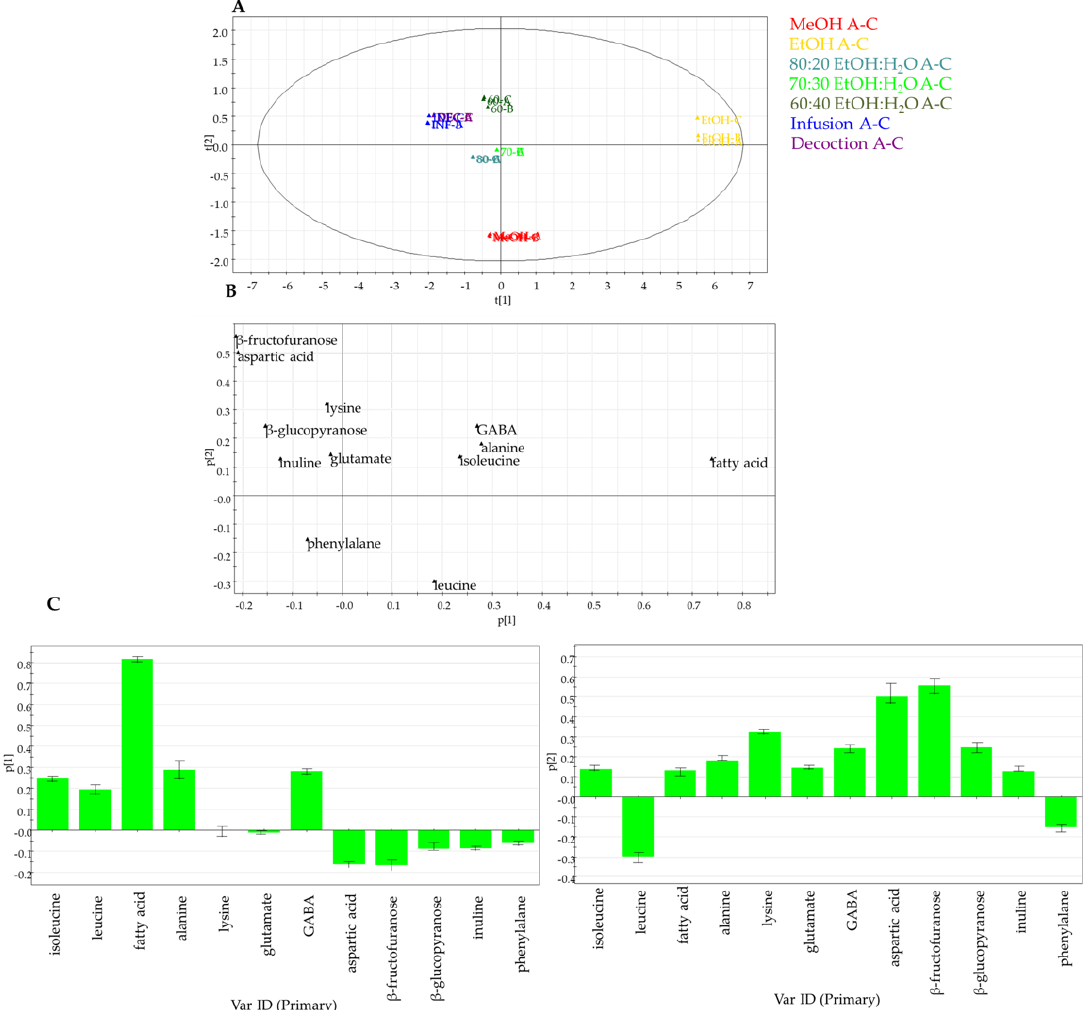
Figure 4. Principal component analysis of primary metabolites in artichoke extracts obtained by NMR targeted analysis: ( A ) PCA score scatter plot; ( B ) PCA loading plot; ( C ) PCA loading column plots.